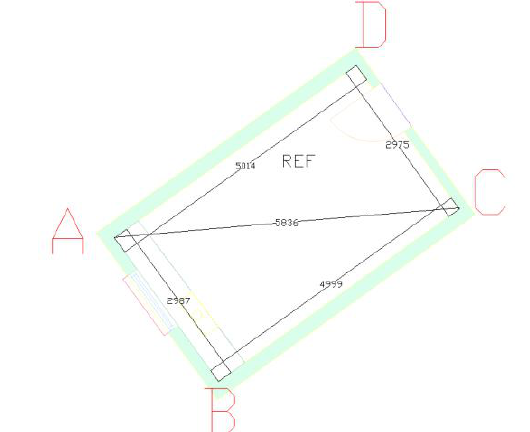
Figure 13. Plan view of reference data and placement of common measurements taken for all datasets